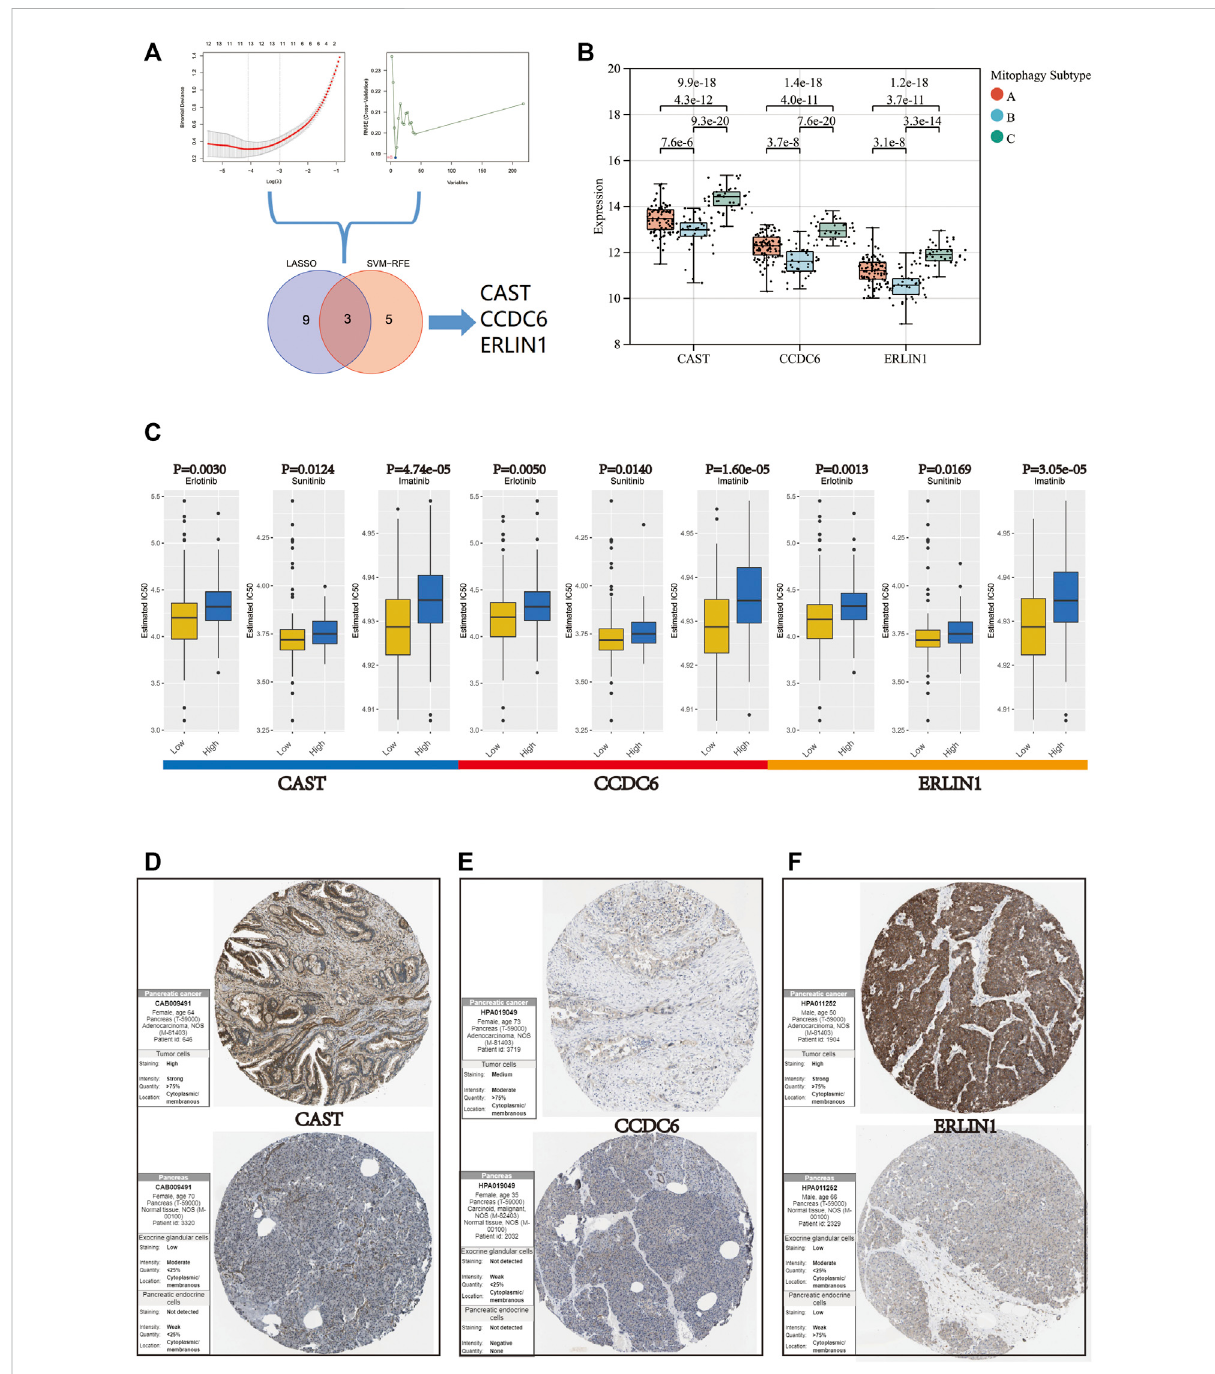
FIGURE 7 (A) Flow chart of the screening procedure. (B) Variation in gene expression levels of CAST, CCDC6, and ERLIN1 across different mitophagy subtypes ( p -values were calculated by the Kruskal Wallis test). (C) Differences in IC 50 of Erlotinib, Sunitinib and Imatinib evaluated by R package “ pRRophetic ” betweenthehighandlowgroupsofCAST,CCDC6,andERLIN1.ImmunohistochemistryanalysisofCAST (D) ,CCDC6 (E) ,andERLIN (F) expression in HPA